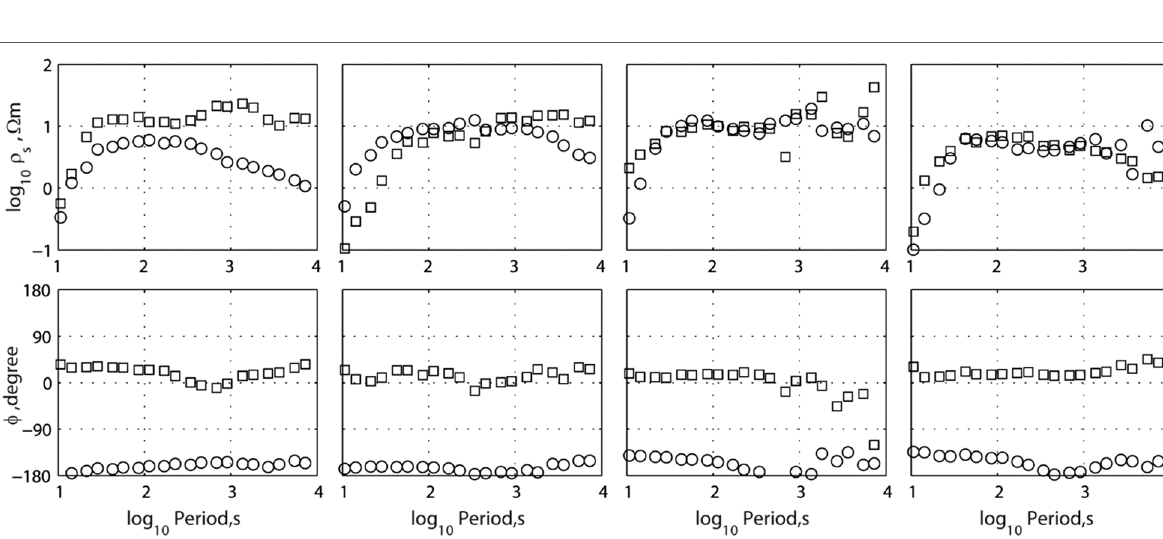
Fig. 10 Results of raw MT data processing, pre-filtered with the adaptive cancellation filter. From left to right, plots show resistivity and phase curves from sites SH-R8, SH-R10, SH-R11, and SH-R13. The xy and yx components are denoted by squares and circles,